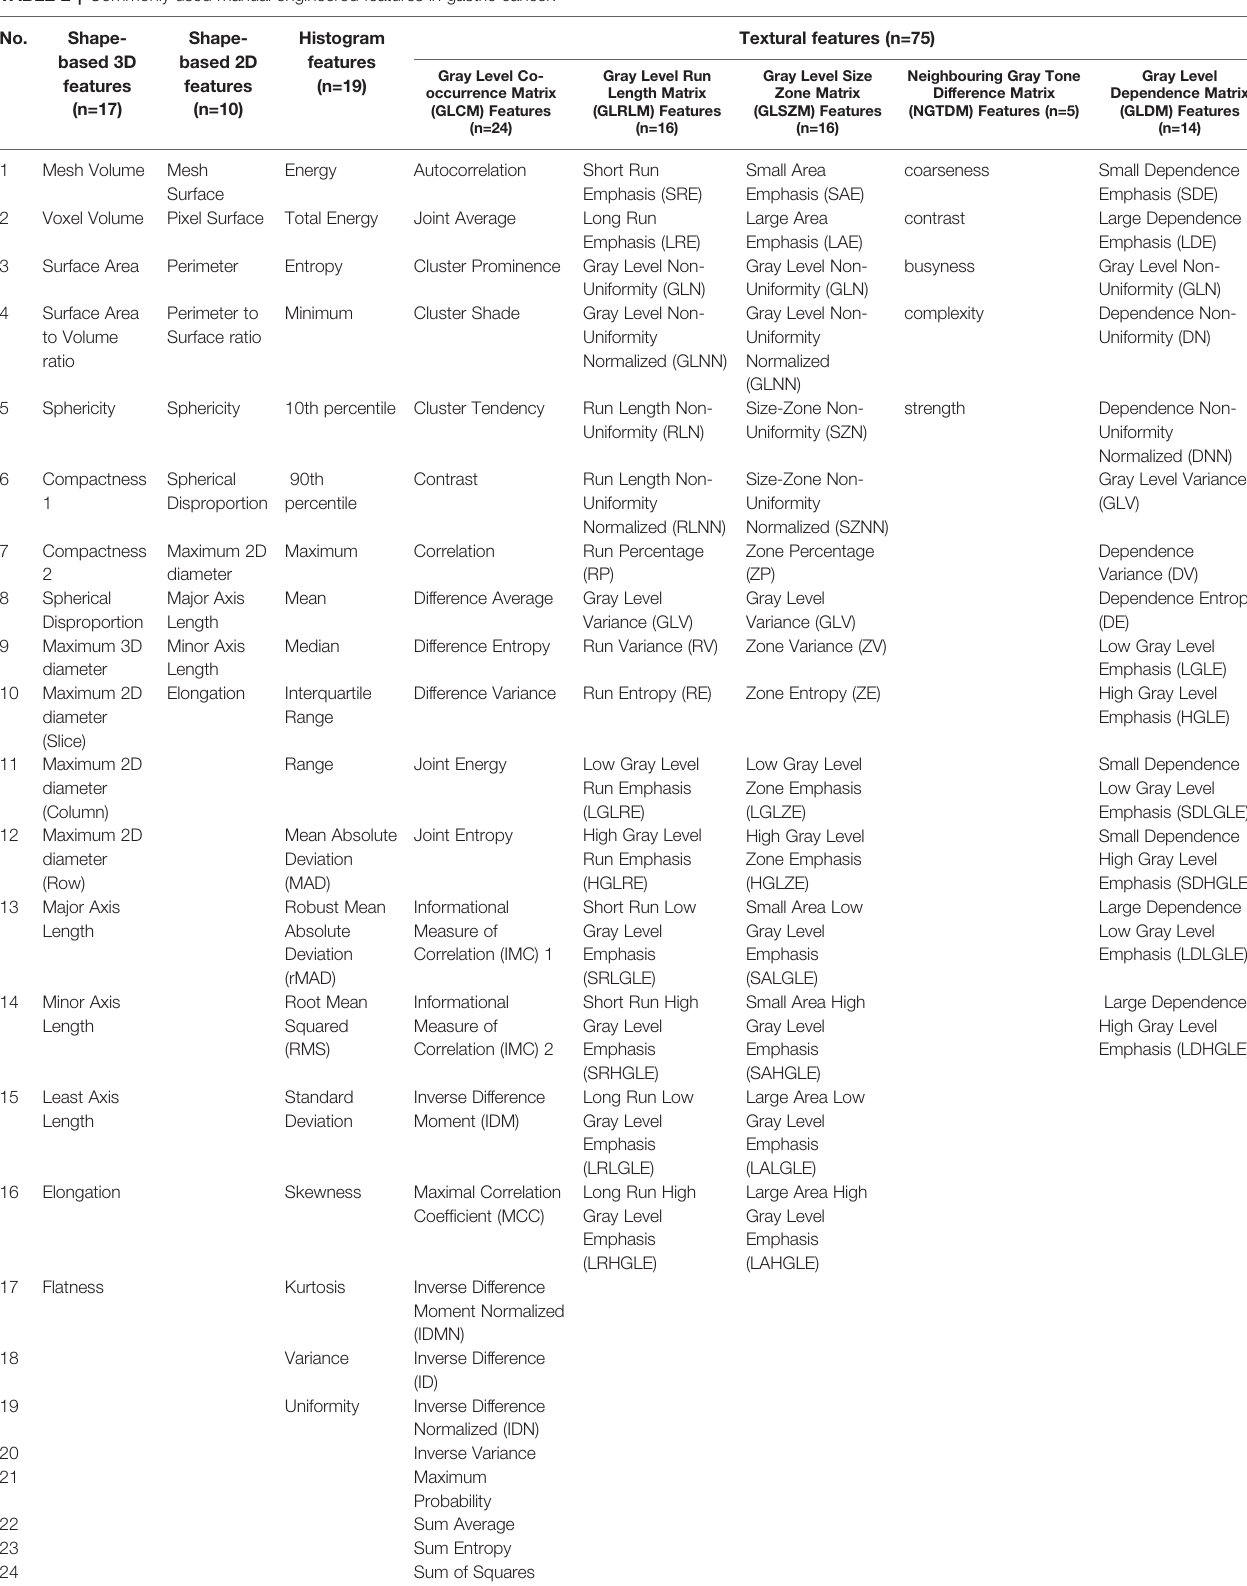
TABLE 2 | Commonly used manual engineered features in gastric